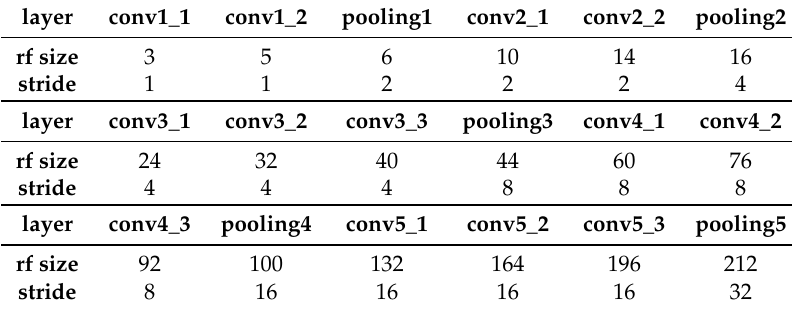
Table 1. The detailed receptive field and stride size in original VGG16